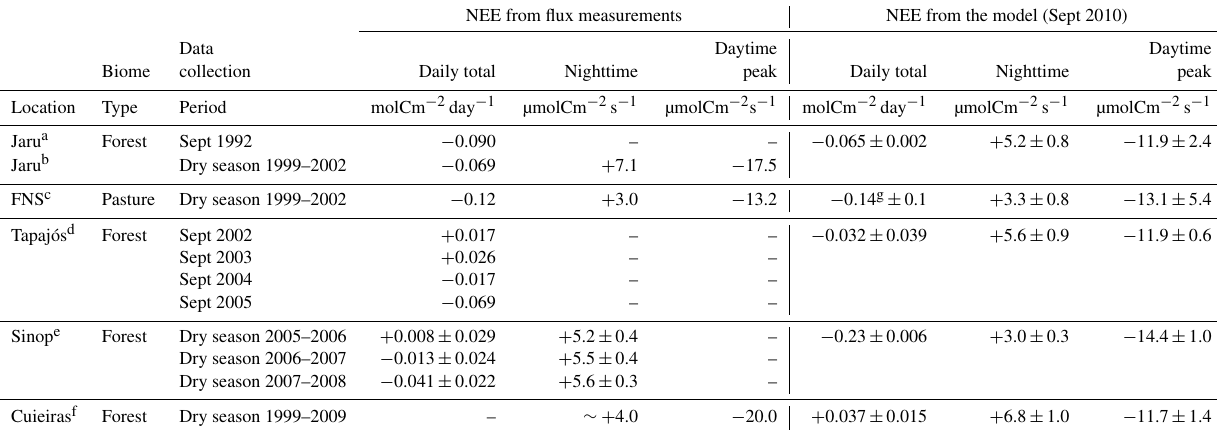
Table 3. NEE measurements during the dry season in several locations in the Amazon region, Brazil. The mean values and standard deviations of NEE from the modeling results from the DIR+DIF experiment (September 2010) are also presented in the last column. NEE from flux measurements NEE from the model (Sept 2010) Data Daytime Daytime